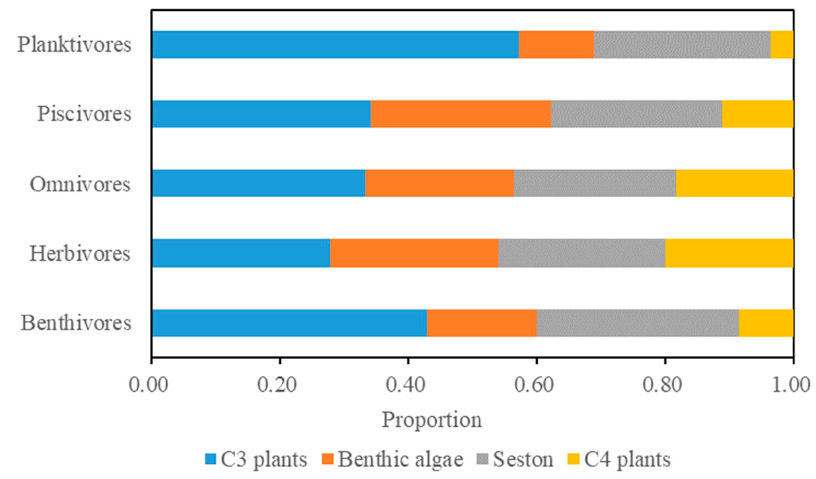
Figure 5. Averages of proportional contributions in four basal carbon sources of different trophic groups in the downstream (backwater zone) of the Daning River. Table 3. Intergroup dissimilarity for each trophic group in the downstream (backwater zone) of the Daning River.